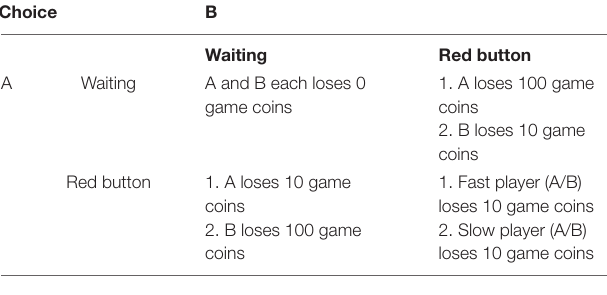
TABLE 2 | The rule of unilateral